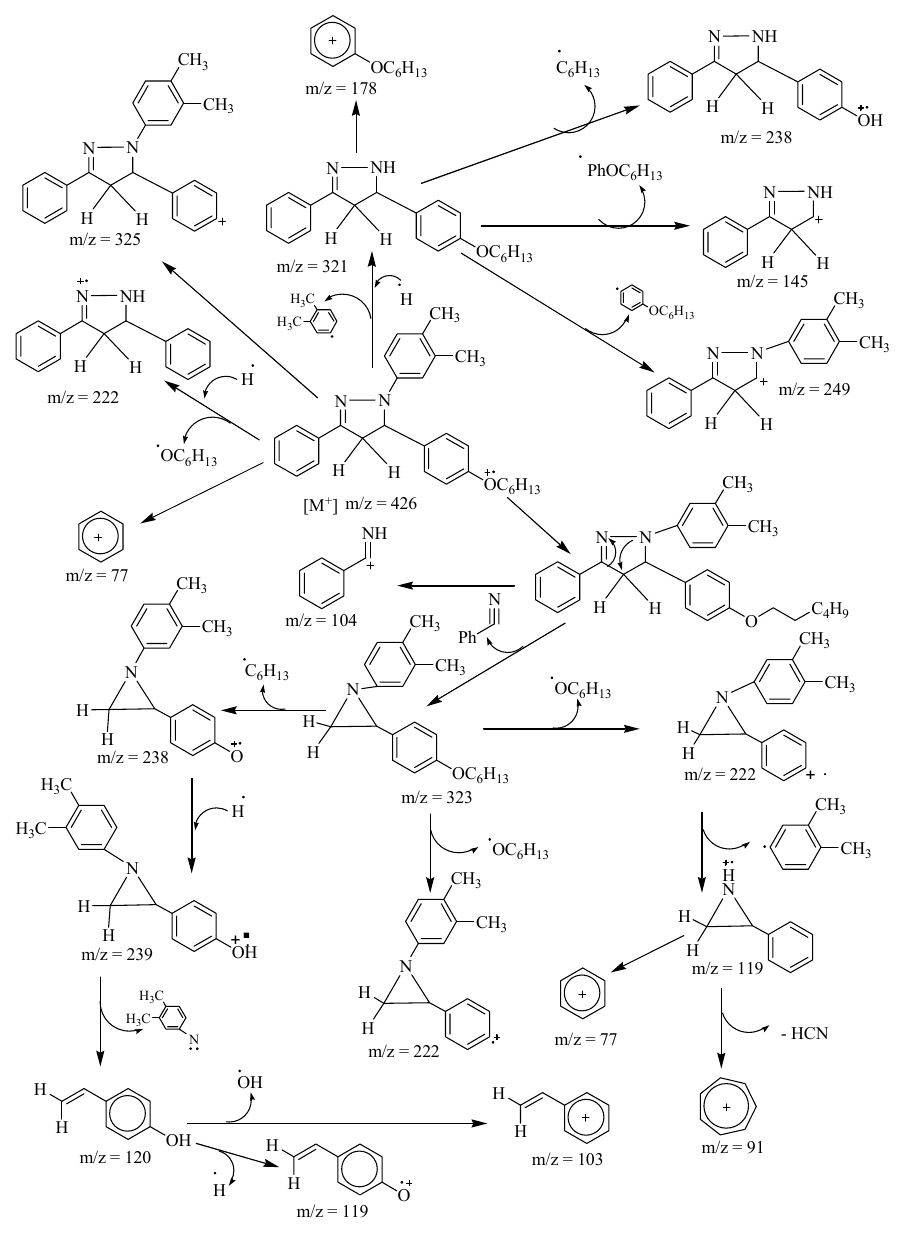
1. Mass fragmentation pattern for 1-(3,4-dimethylphenyl)-3-phenyl-5-(4- hexyloxyphenyl)-2-pyrazoline ( 6h ).